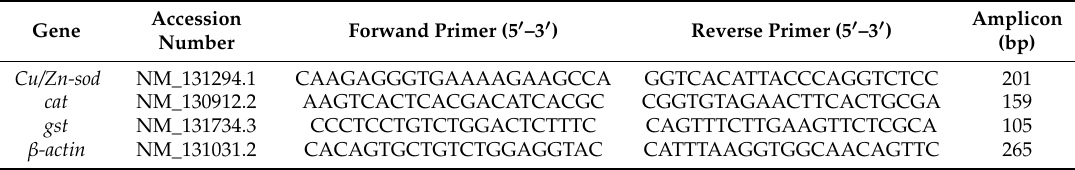
Table 1. Primer sequences used for amplification of antioxidant response-related genes with the qRT-PCR. Accession Gene